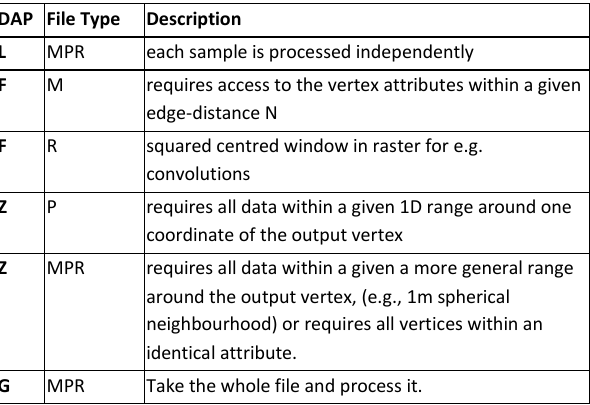
Table 4. Relationship between data access patterns and file groups